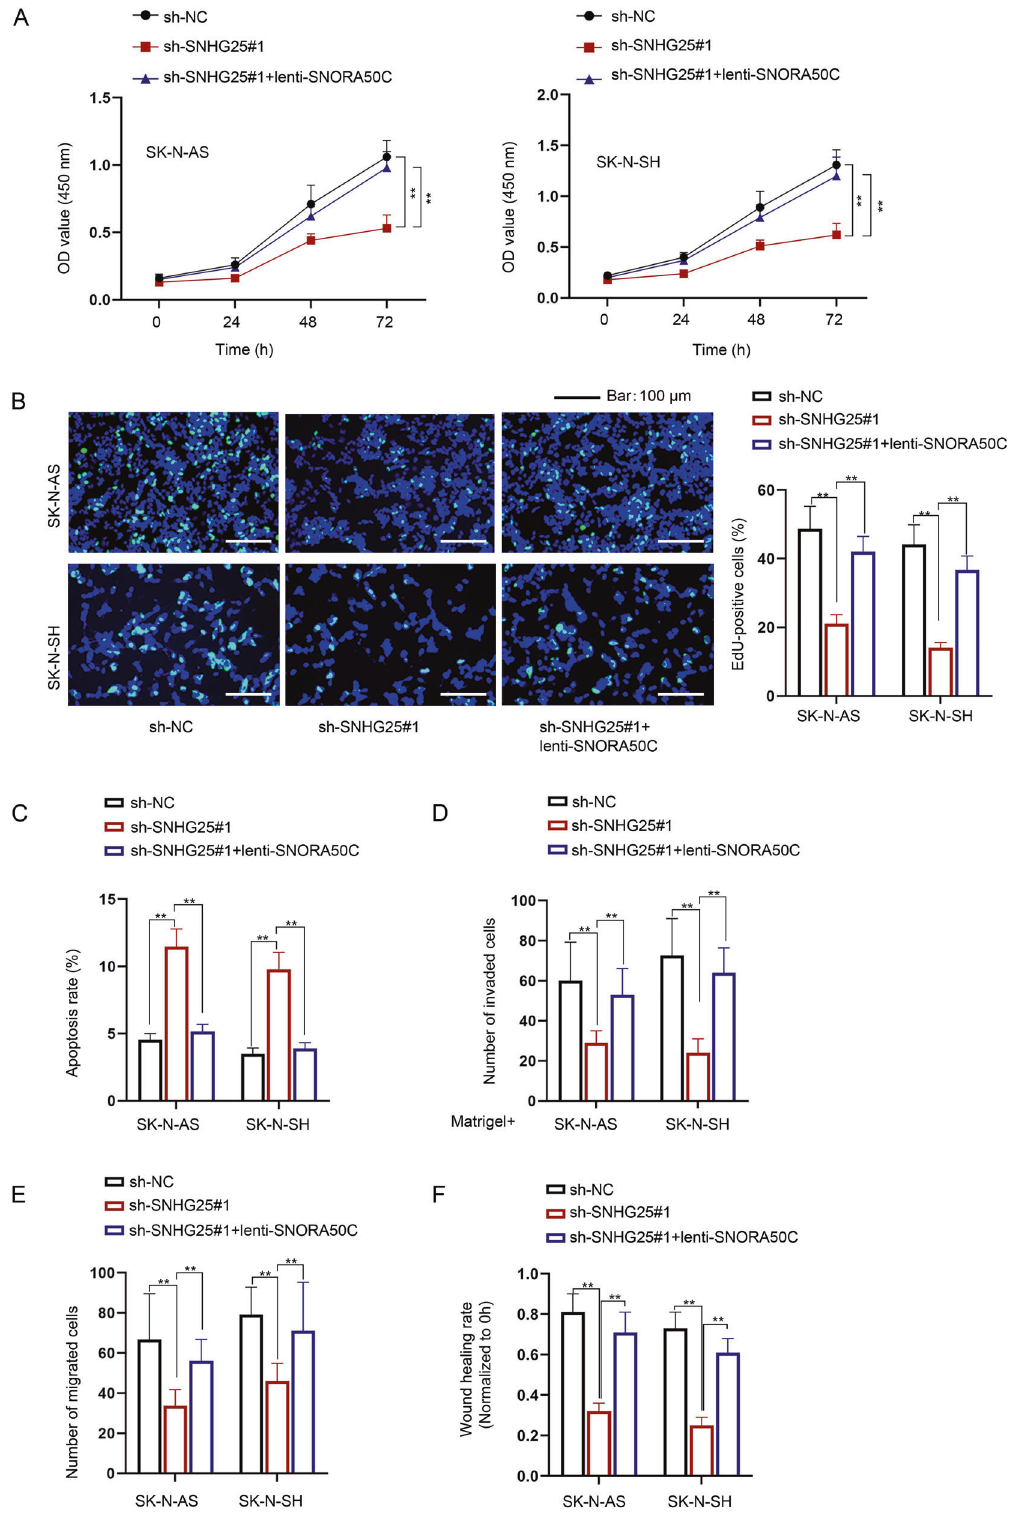
Fig. 4 SNHG25 promotes NB cell malignant behaviors via upregulating SNORA50C. Rescue assays were performed in SK-N-AS and SK-N-SH cells transfected with sh-NC, sh-SNHG25#1, and sh-SNHG25#1 + lenti-SNORA50C, respectively. A – C CCK-8 assay, colony formation assay, and fl ow cytometry analysis detected the proliferation and apoptosis of SK-N-AS and SK-N-SH cells. D – F Transwell and wound healing assays detected the invasion and migration of SK-N-AS and SK-N-SH cells. One-way ANOVA, Tukey. ** P < 0.01. Error bars indicate mean ± SD. ( N = 3).